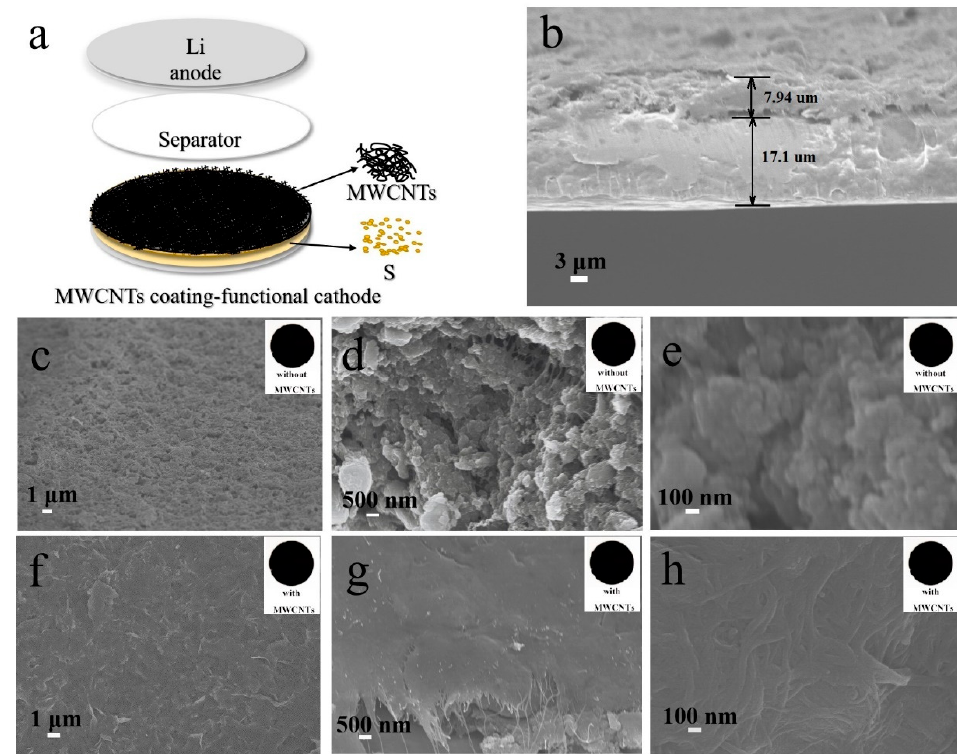
Figure 3. ( a ) Schematic drawing of the MWCNTs coating cathode, ( b ) SEM image of the cathode side with MWCNTs coating, ( c – e ) SEM images of the cathode without MWCNTs coating, ( f – h ) cathodes with MWCNTs coating.